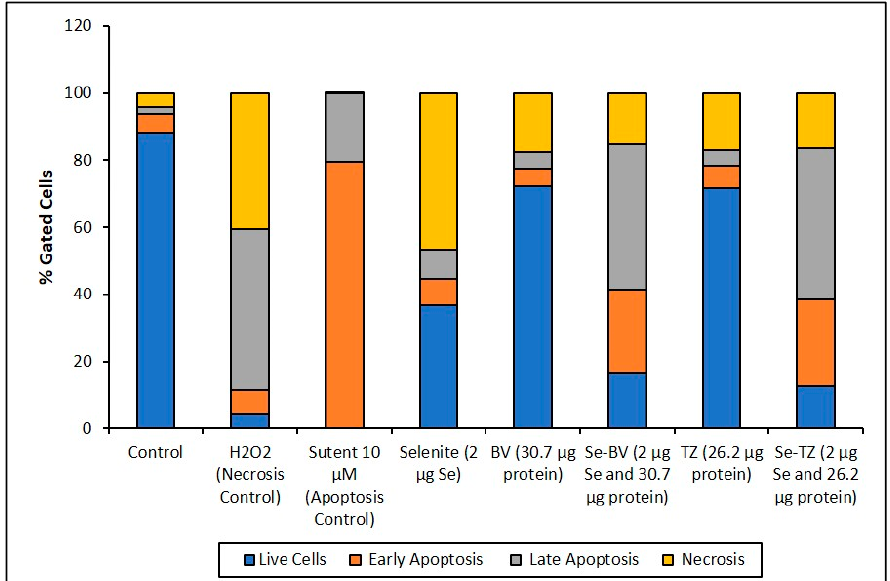
Figure 12. Cell representation (%) within the four quadrants for MDA-MB-468 cell treatments. Percent distribution of MDA-MB-468 apoptotic cells after treatment with H 2 O 2 , Sutent, Selenite as Se, Bevacizumab (BV), Selenobevacizumab (Se-BV), Trastuzumab (TZ), or Selenotrastuzumab (Se-TZ). Data is expressed as the Mean ( n = 3).